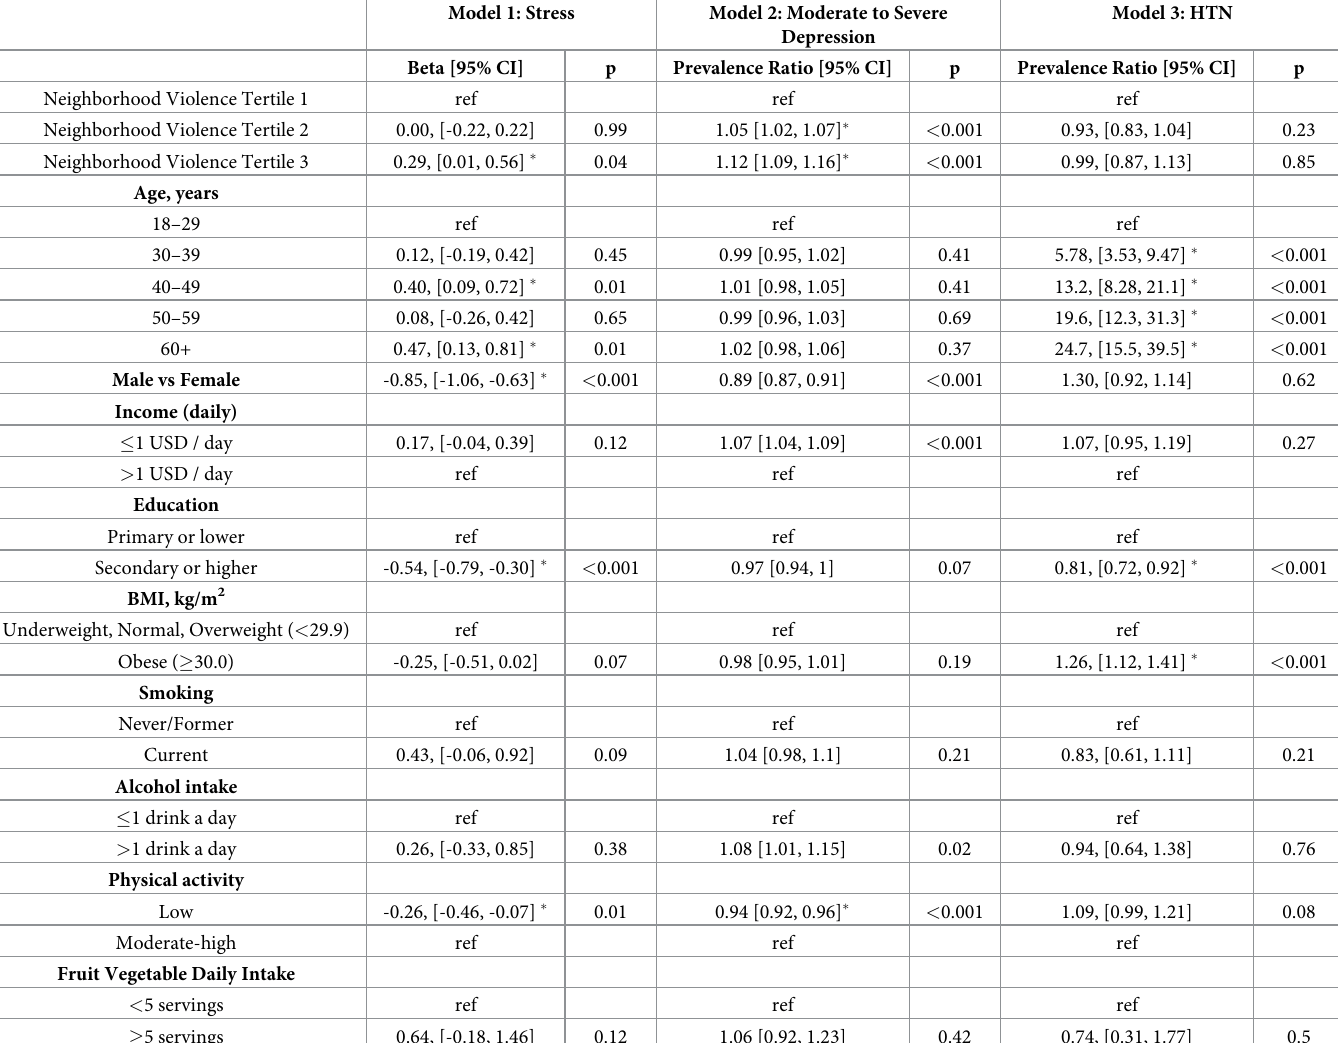
Table 4. Association between neighborhood violence and mental or physical health outcomes, multivariable linear regression and Poisson